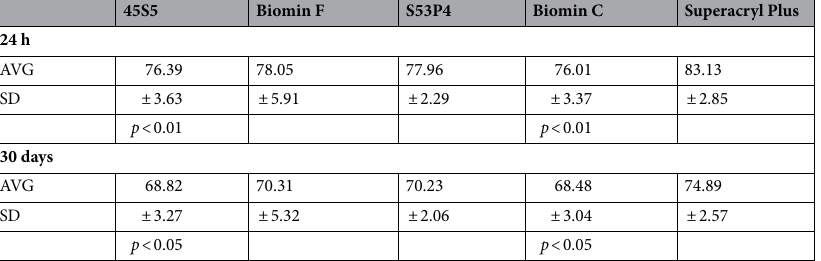
Table 2. Flexural strength [MPa] after 24 h and 30 days for four different types of glasses and PMMA resin (Superacryl Plus) as the reference. Flexural strength for samples 45S5 and Biomin C is statistically significant at the confidence level of p < 0.01 compared with the reference Superacryl Plus. After 30 days of immersion, the same flexural strength for samples 45S5 and Biomin C is statistically significant at the confidence level of p < 0.05 compared with the reference Superacryl